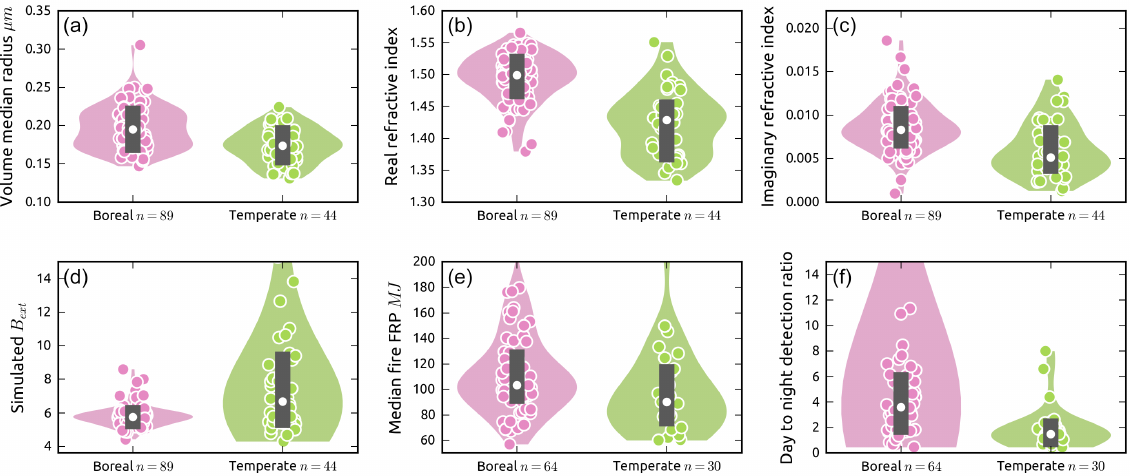
Figure 3. Distributions of AERONET-retrieved particle properties (a–c) attributed to boreal and temperate fires, simulated mass extinction efficiencies (d) , median MODIS FRP values (e) and ratios of daytime to night-time active fire detection counts observed during a single overpass (f) . Shown are kernel density estimates and individual observations; boxes indicate median values and interquartile range.